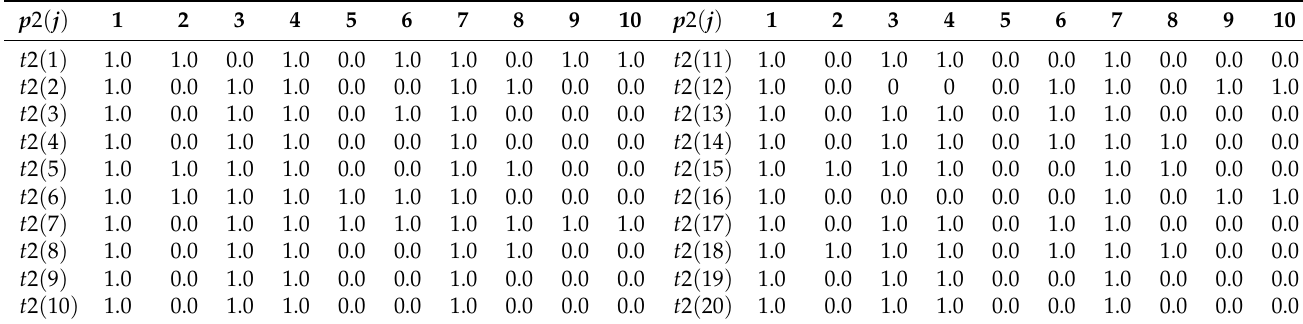
Table 3. Water scenic spot functional attribute